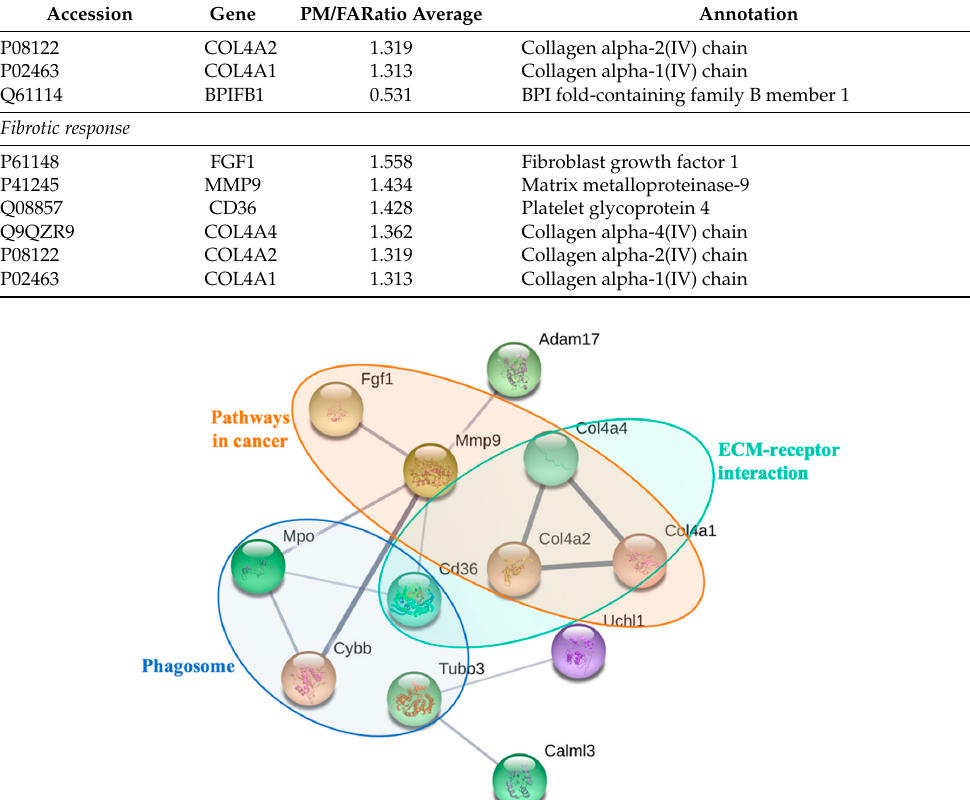
Figure 4. The analysis of the functional interaction network of PM 2.5 -regulated proteins by the search tool for the retrieval of interacting genes/proteins (STRING) algorithm.